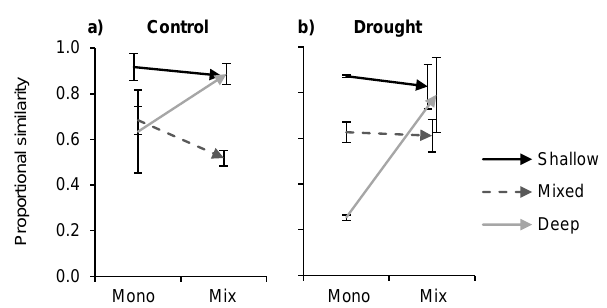
Figure 5. The proportional similarity (Eq. 1) of the proportional water uptake from the different soil depth intervals of shallow-rooting ( L. perenne – T. repens ), mixed-rooting (refers to combinations of shallow- and deep rooting species, and is the mean of L. perenne–C.